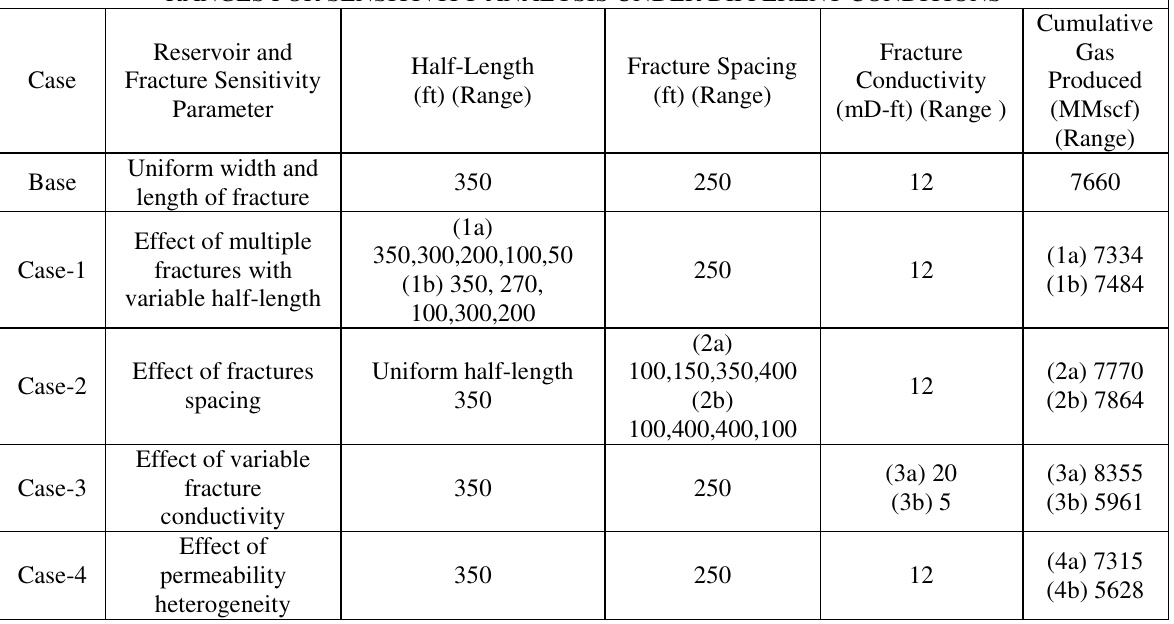
TABLE 2. THE KEY PARAMETERS USED TO MODEL THE EXAMPLE RESERVOIR AND THEIR RANGES FOR SENSITIVITY ANALYSIS UNDER DIFFERENT